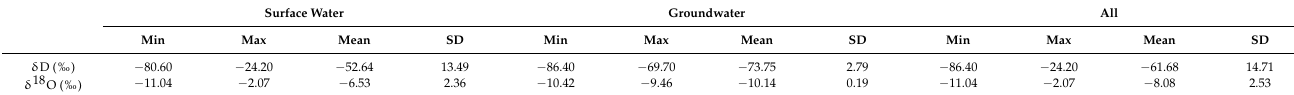
Table 5. Statistical characteristics of hydrogen and oxygen isotopes.